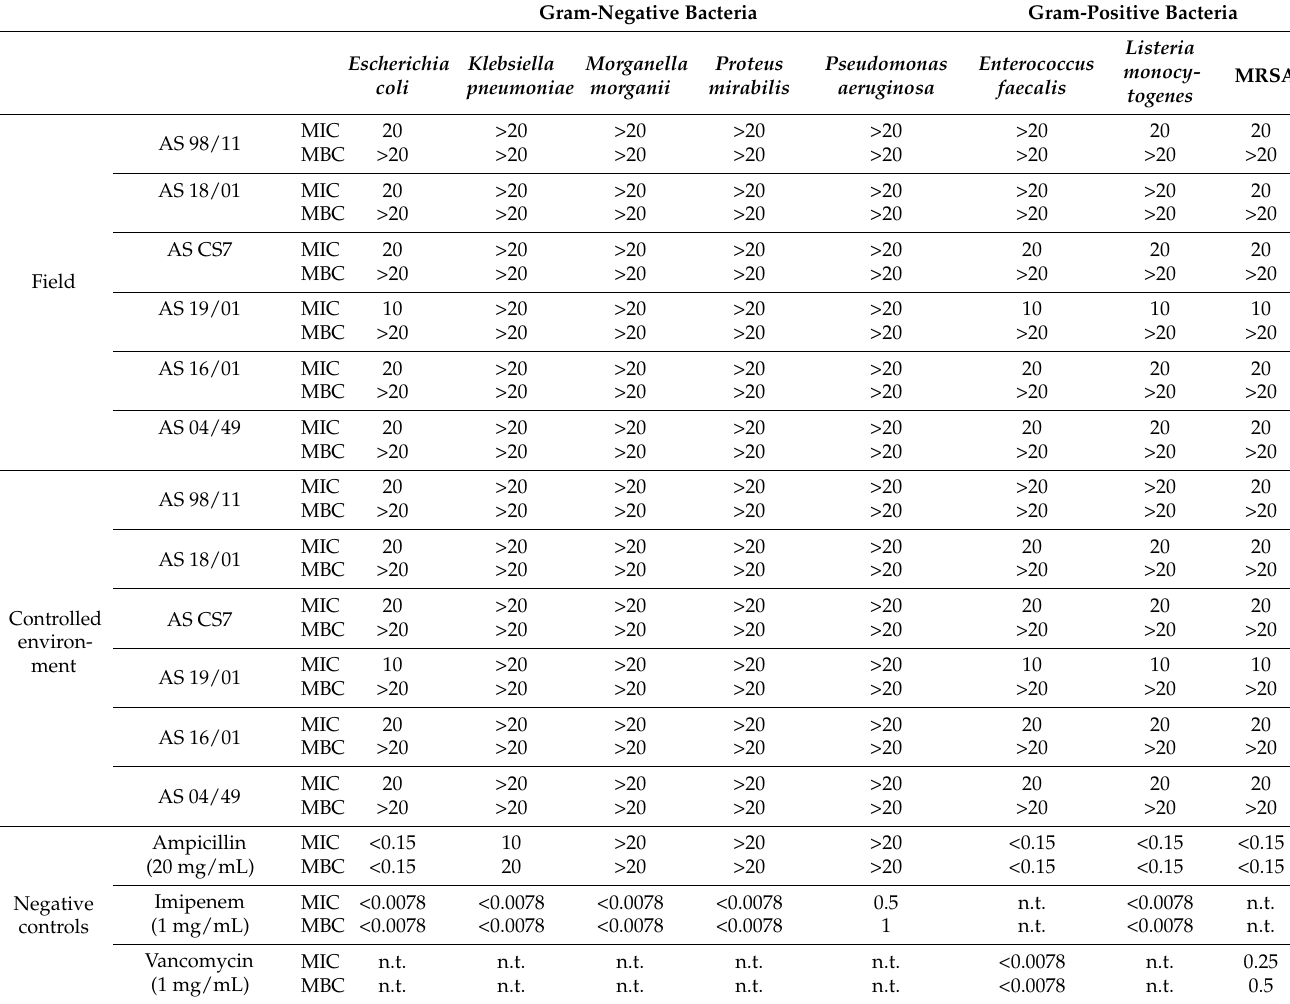
Table 4. Antibacterial activity (MIC and MBC, mg/mL) of hydromethanolic extracts of the studied Agaricus subrufescens samples produced in the field and in controlled environment